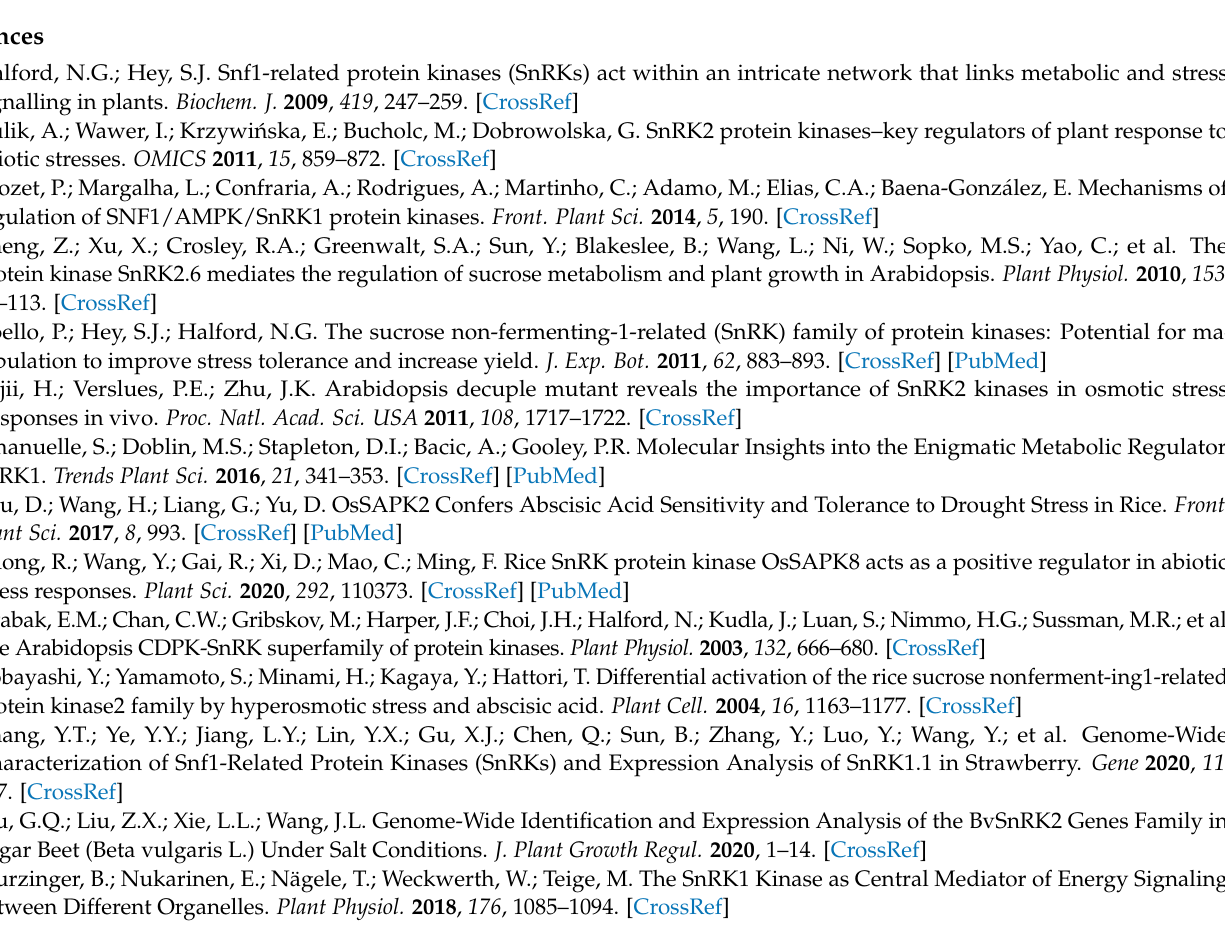
Figure S1: Expression profiles of 10 DoSnRK genes in leaf, stem, and root tissues by qRT-PCR assay. The relative expression levels were obtained from the average of three repeats. The bars stand for the standard deviation. Table S1: The predicted cis-elements in the promoter regions of DoSnRK genes. Table S2: The primer sequences used in the qRT-PCR